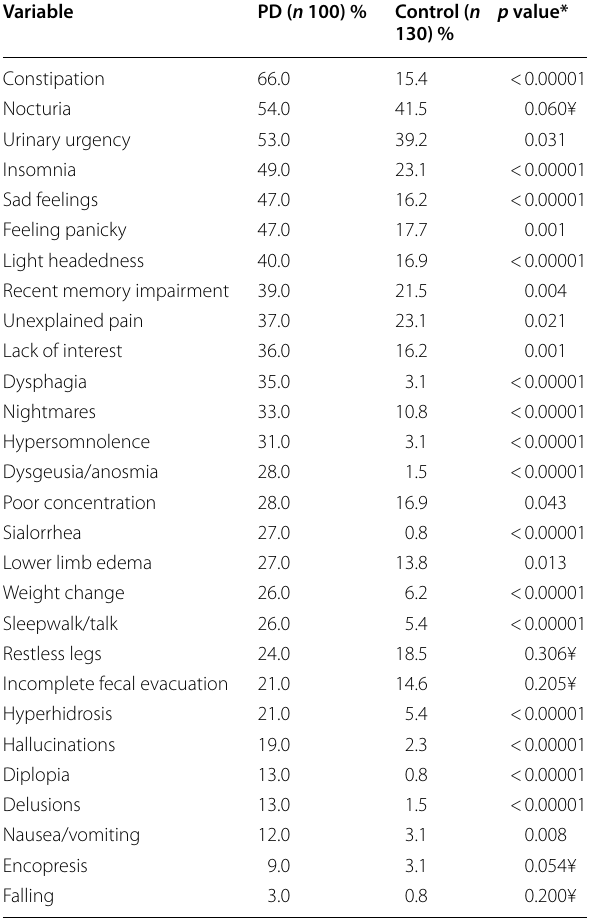
Table 1 Demographic data in Parkinson’s disease patients and control group